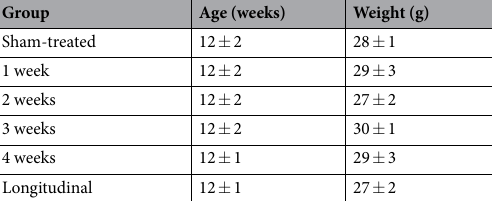
Table 1. Baseline animal characteristics in each